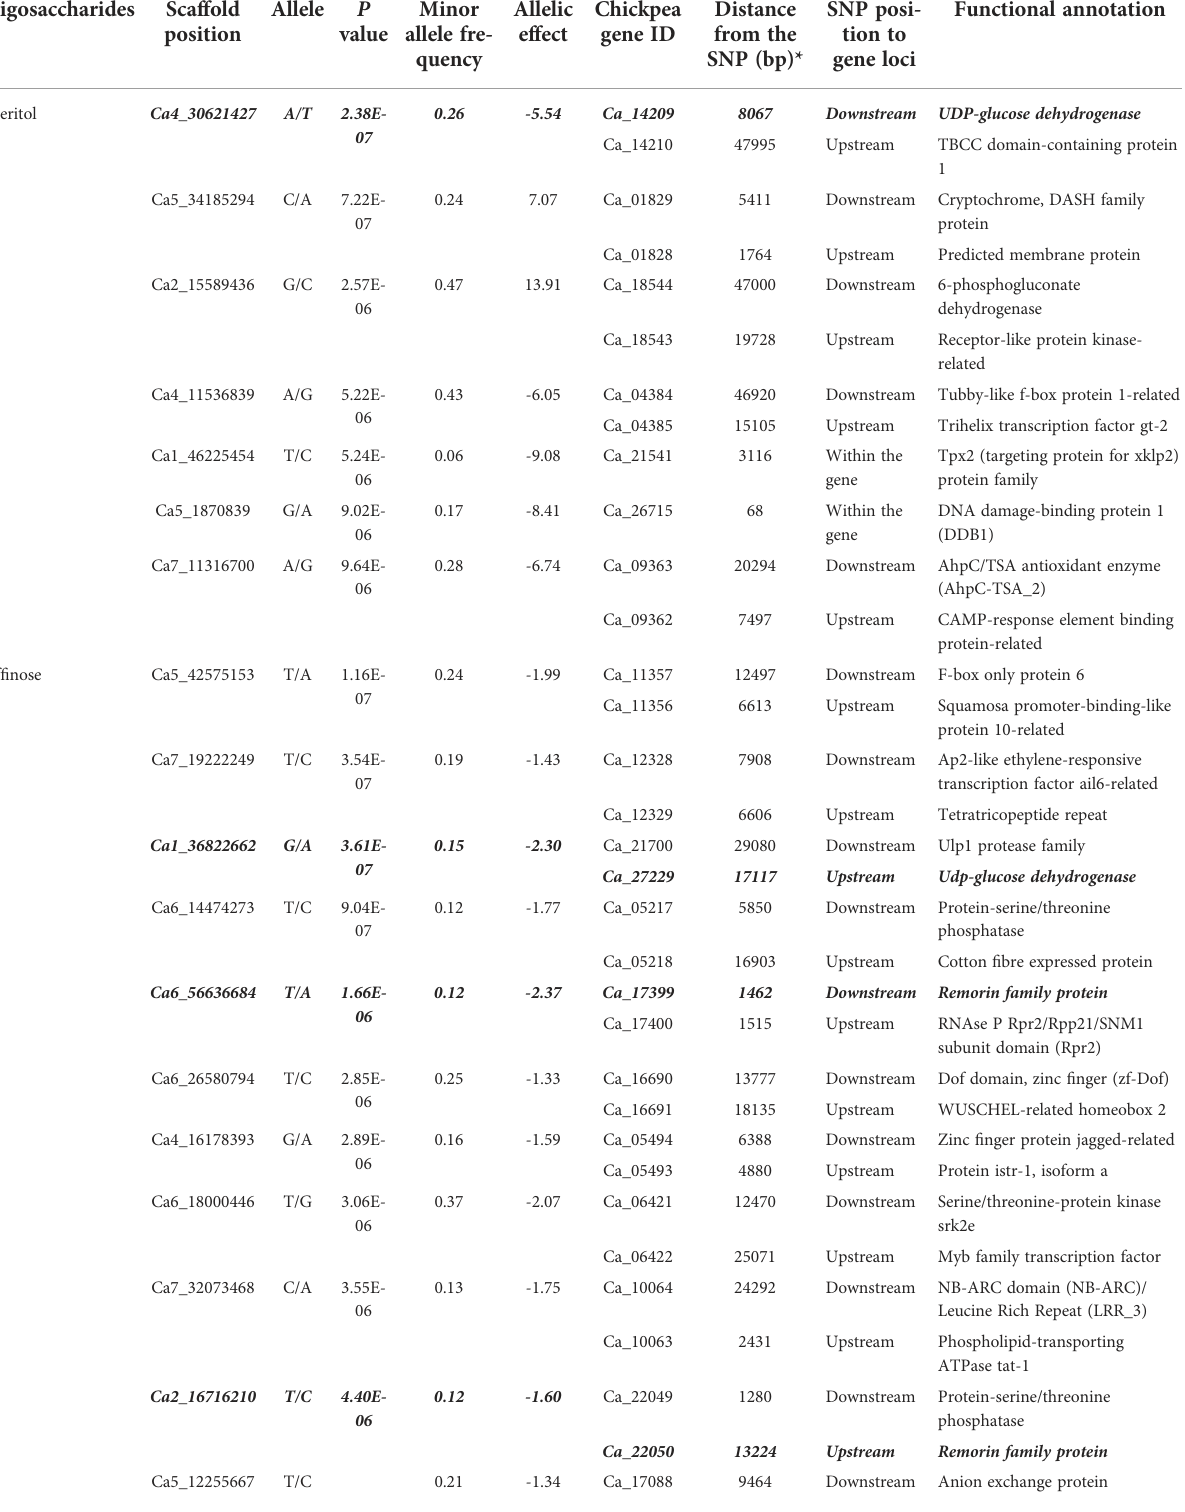
TABLE 2 List of signi fi cant single nucleotide polymorphic associations, the genes tagged by signi fi cant single nucleotide polymorphic markers, and candidate genes identi fi ed based on proximity to the signi fi cant markers and their description for ciceritol, raf fi nose, stachyose, sucrose, and total sugars in